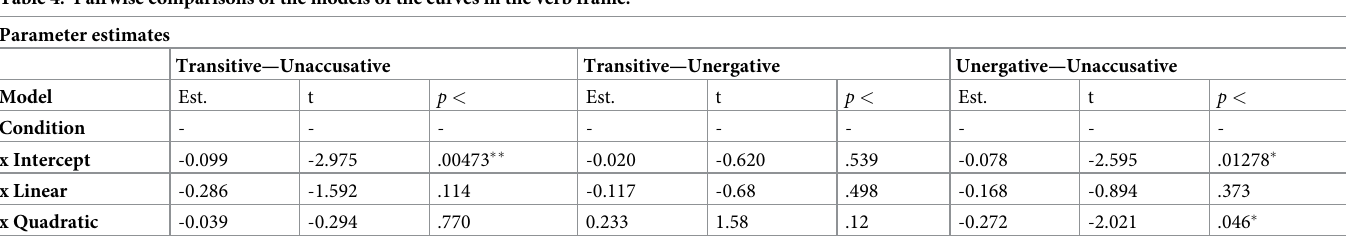
Table 4. Pairwise comparisons of the models of the curves in the verb frame. Parameter